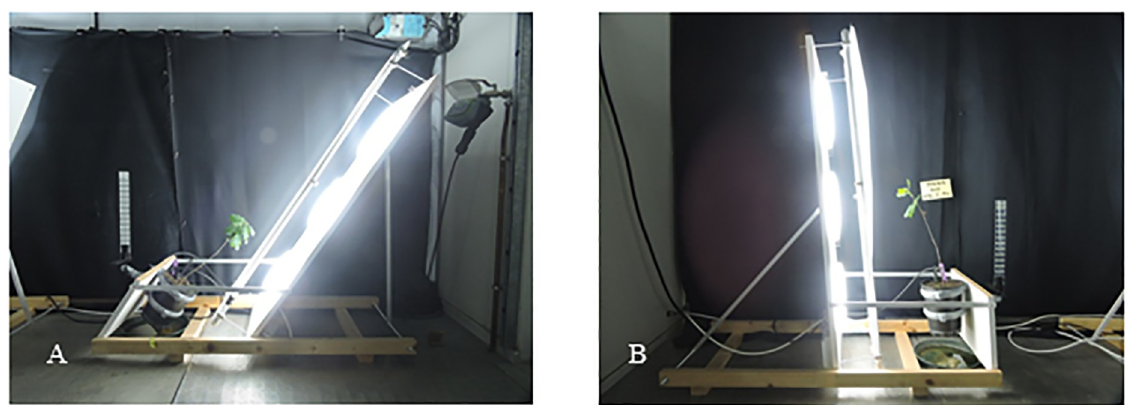
Fig 3. Side views of the anisotropic light device installed in a growth chamber. A: Young oak is installed on the anisotropic light device tilted 35˚ from the vertical. B: Young oak is installed on the anisotropic light device tilted 5˚ from the vertical. The walls of the growth chamber were covered with black curtains in order to avoid light